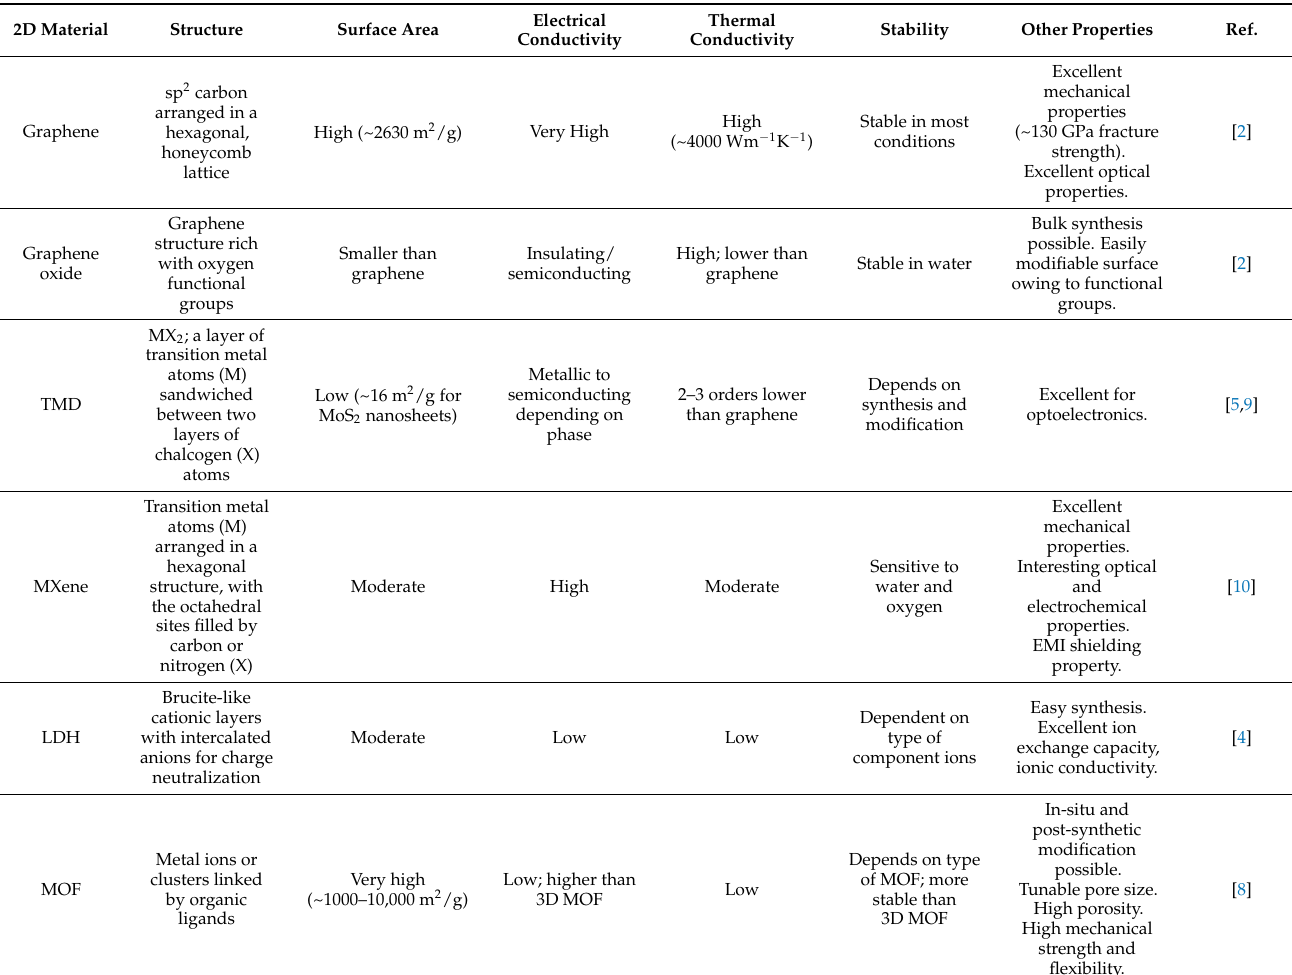
Table 1. Comparison of 2D MOFs with other 2D